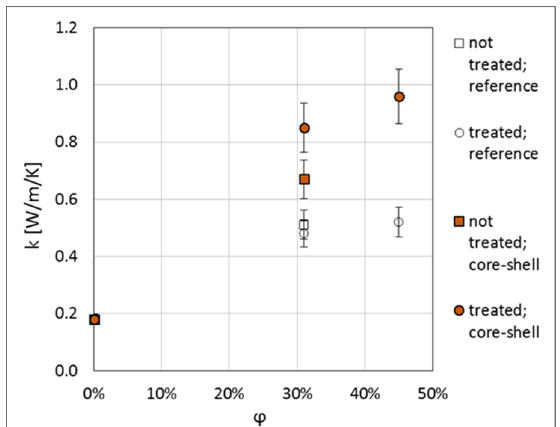
Figure 8. Thermal conductivity results for composites filled with core-shell (filled points) and reference fillers (open points). Squares correspond to the fillers without surface treatment, circles to the fillers treated with silane. Measurement errors of 10% are assumed (see text). Table 1. Thermal conductivity results obtained at room temperature.